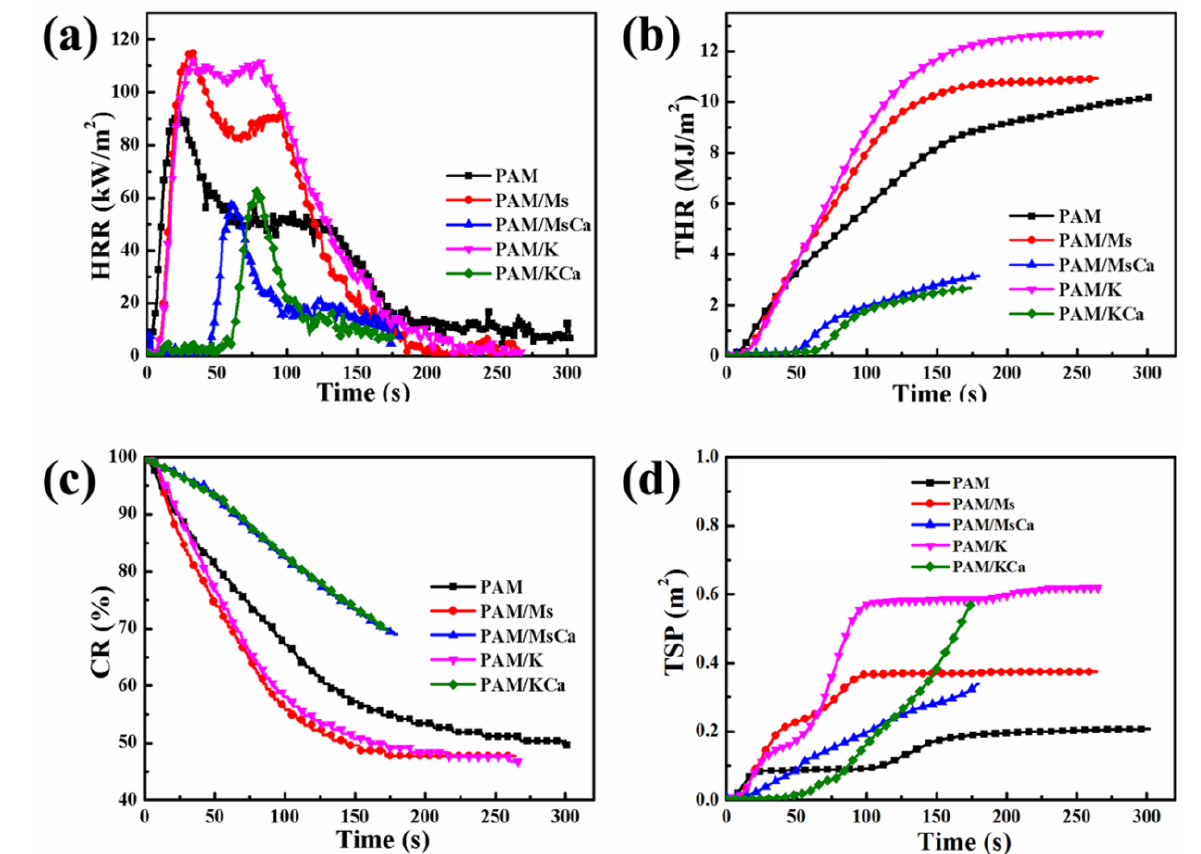
Figure 5. Cone calorimeter curves of the different PAM aerogels. Heat release rate (HRR) of the different PAM composite aerogels versus time curves ( a ), Total heat release (THR) versus time curves ( b ), Char residues (CR) yields versus time curves ( c ), and ( d ) Total smoke release (TSR) versus time curves at a heat flux of 35 kW/m 2 .